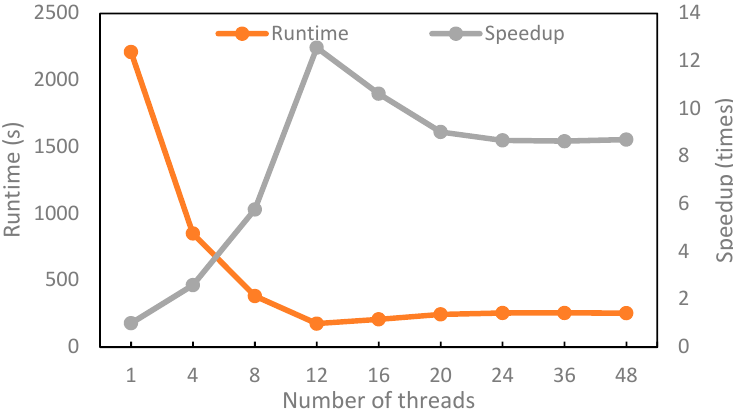
Figure 9. Runtime of the proposed parallelized matching method.